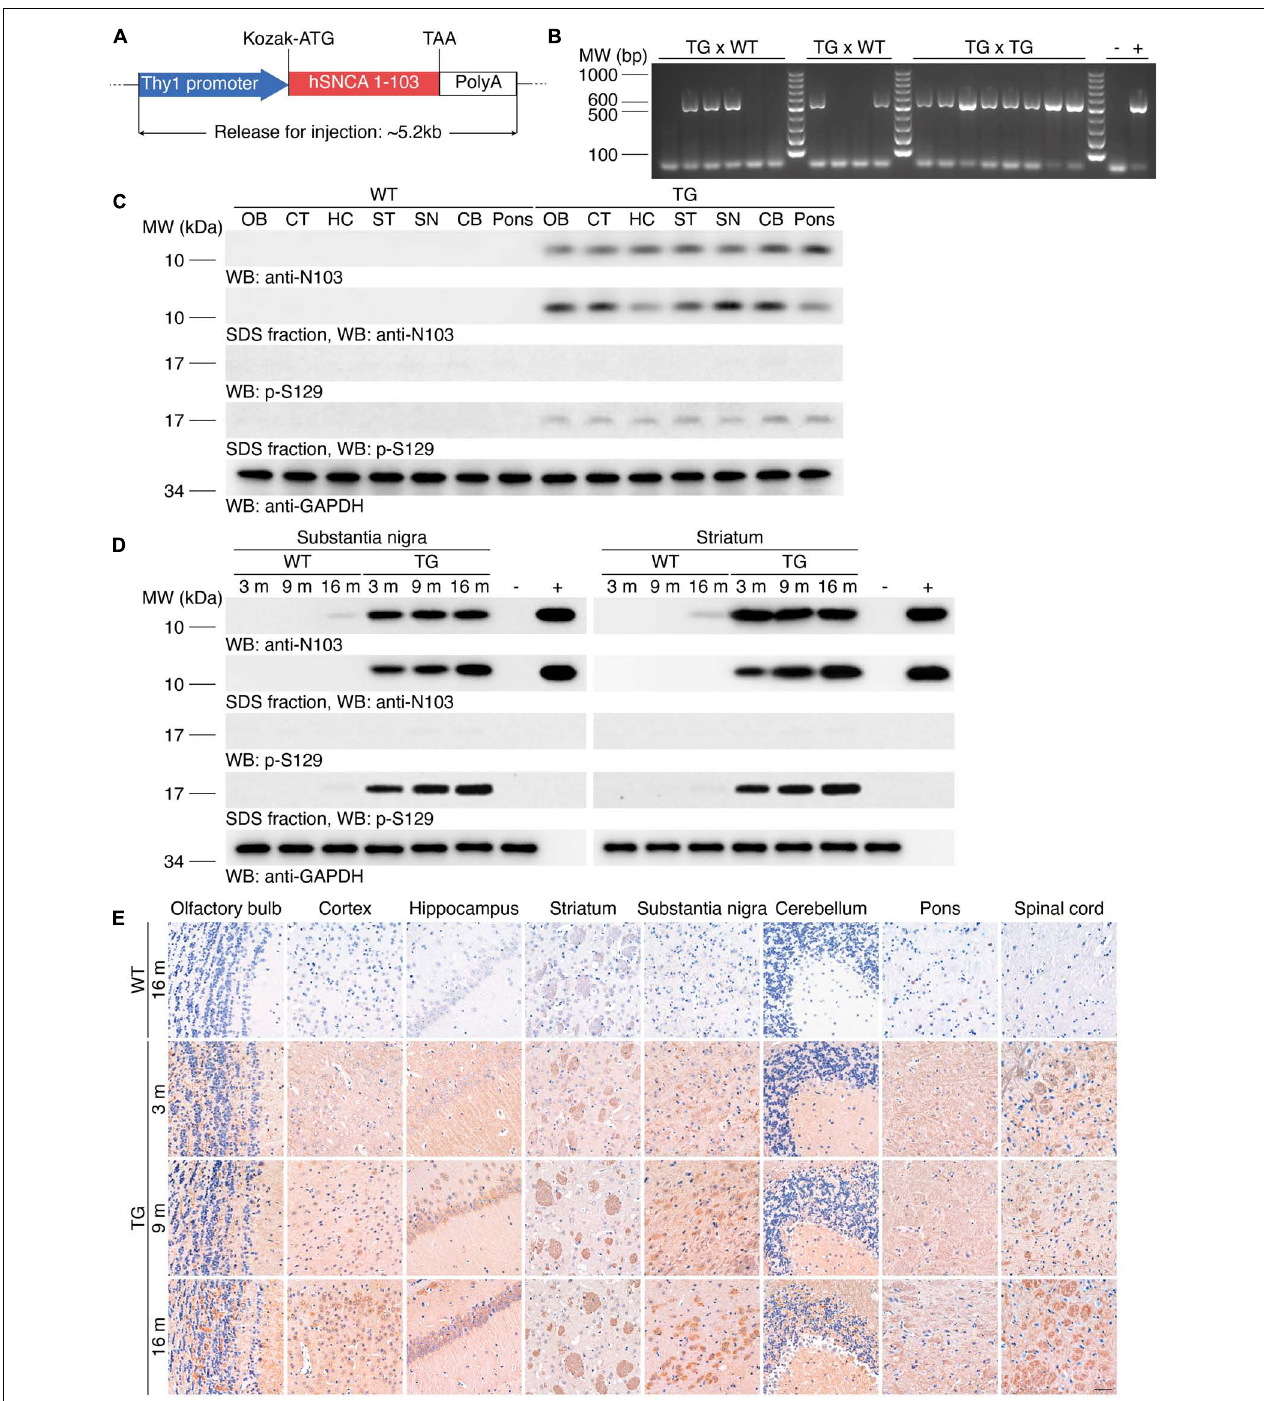
FIGURE 1 | Generation of the N103 mouse line. (A) Schematic of the imported Thy1- α -synuclein 1-103 sequence. Kozak sequence (GCCGCCACC) was added before the start codon ATG for the ribosome to recognize the initiation codon. (B) Genotyping of the N103 mice. DNA samples of WT mice and N103 founder mice were loaded as negative control and positive control, respectively. (C) Western blots showing the expression of the α -synuclein 1-103 and α -synuclein p-S129 in soluble and insoluble fractions within various regions of the brains of the 6-month-old WT mice and N103 mice. GAPDH was used as the loading control in the soluble fractions. OB, olfactory bulb; CT, cortex; HC, hippocampus; ST, striatum; SN, substantia nigra; CB, cerebellum. (D) Western blots showing the soluble and insoluble α -synuclein 1-103 and α -synuclein p-S129 in the substantia nigra and striatum of the mouse brains. Brain lysates of 2-months-old WT mice and recombinant human α -synuclein 1-103 fragment were used as negative control and positive control, respectively. (E) Immunohistochemistry of α -synuclein 1-103 in different areas of the central nervous system in WT mice and N103 mice. Scale bar, 40 µ m.